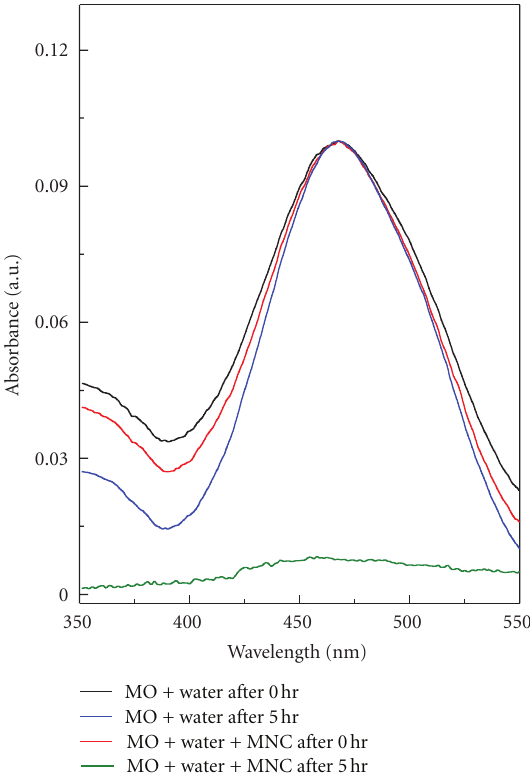
Figure 5: Absorbance spectra of methyl orange loaded with and without MNCs/water and UV irradiation for 5 hours. The irradiation was carried out with a 12mW Xenon lamp with a main wavelength of 400